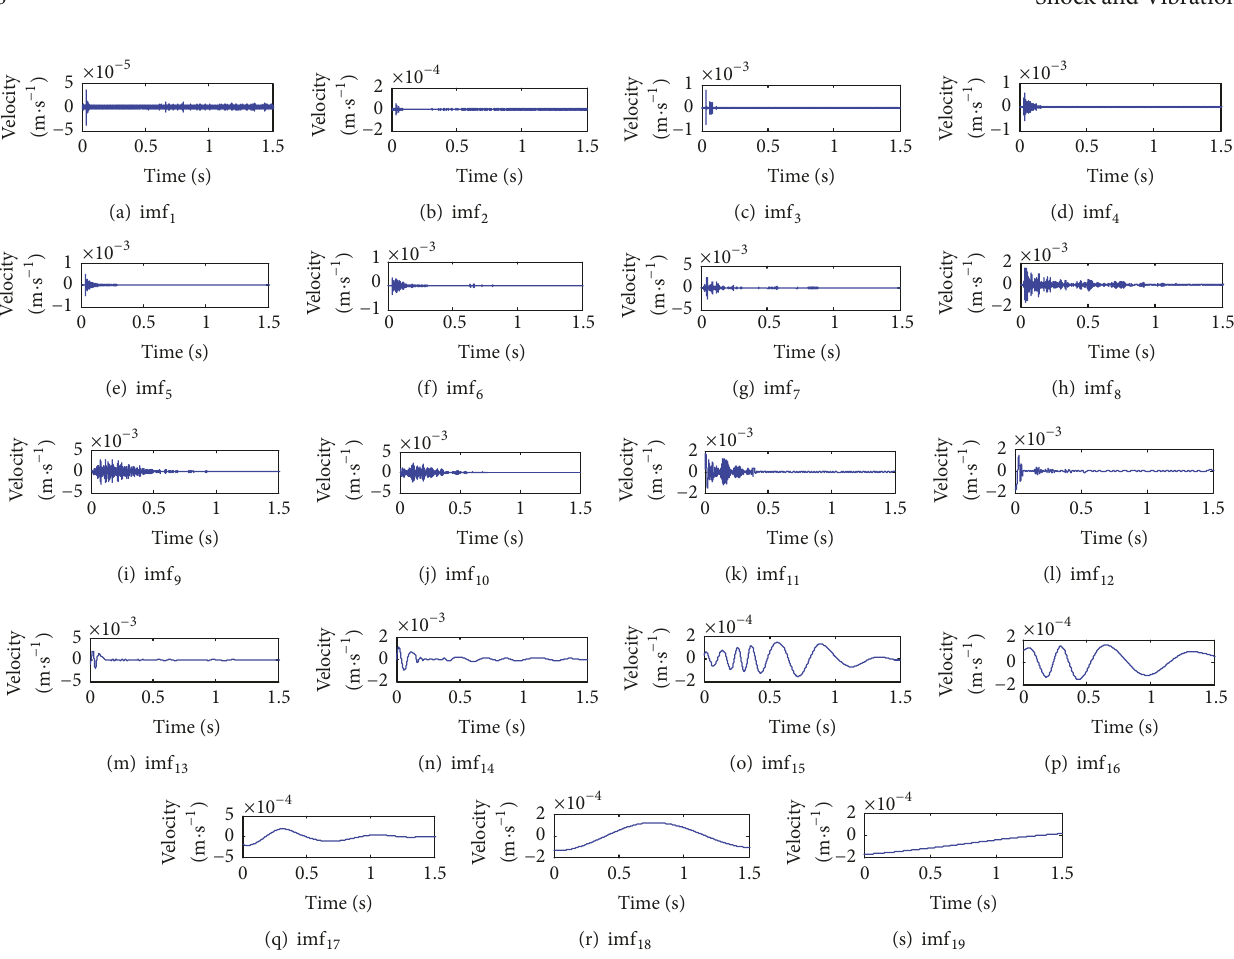
Figure 7: IMF components of the vibration velocity at the inner surface of explosive